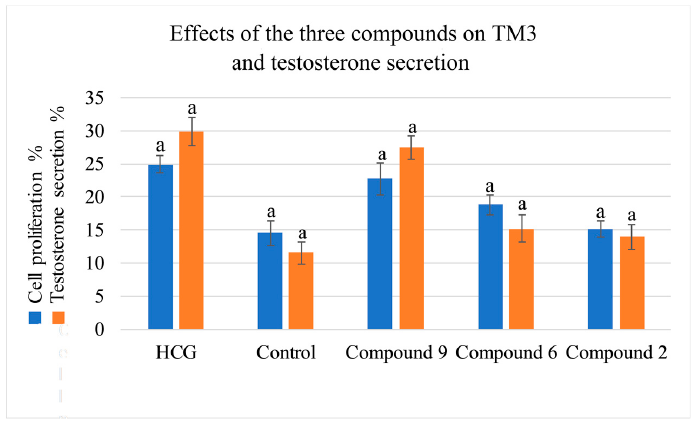
Figure 6. Effects of the three compounds on TM3 and testosterone secretion (a p <